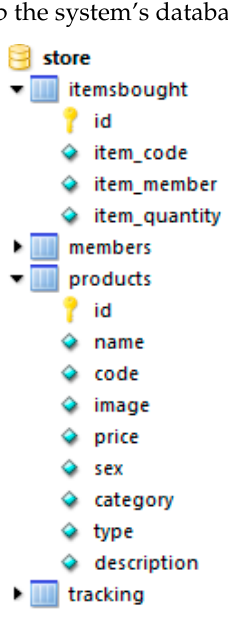
Figure 4. Database tables